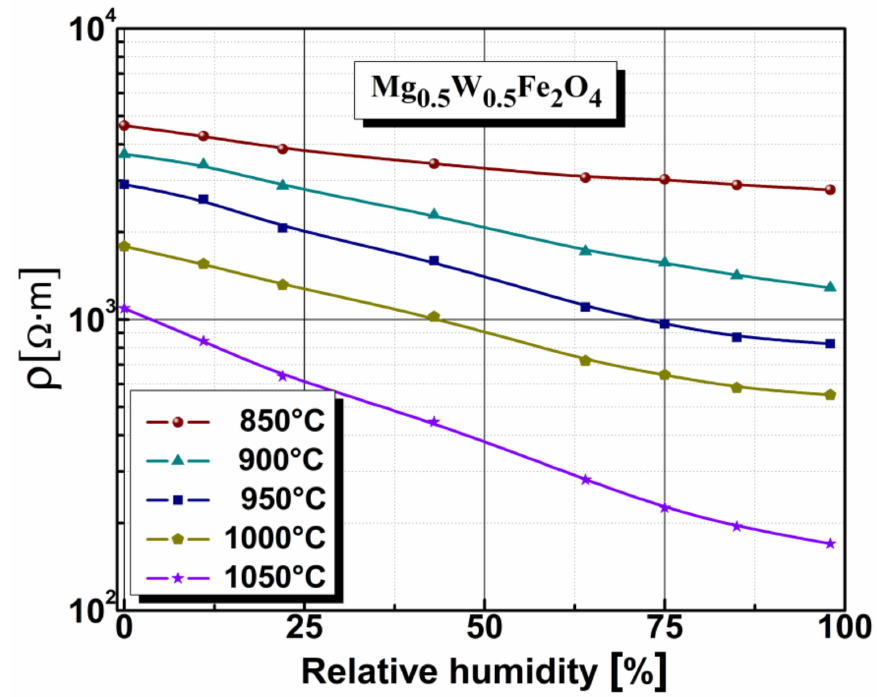
Figure 8. Electrical resistivity characteristics under humidity conditions for Mg 0.5 W 0.5 Fe 2 O 4